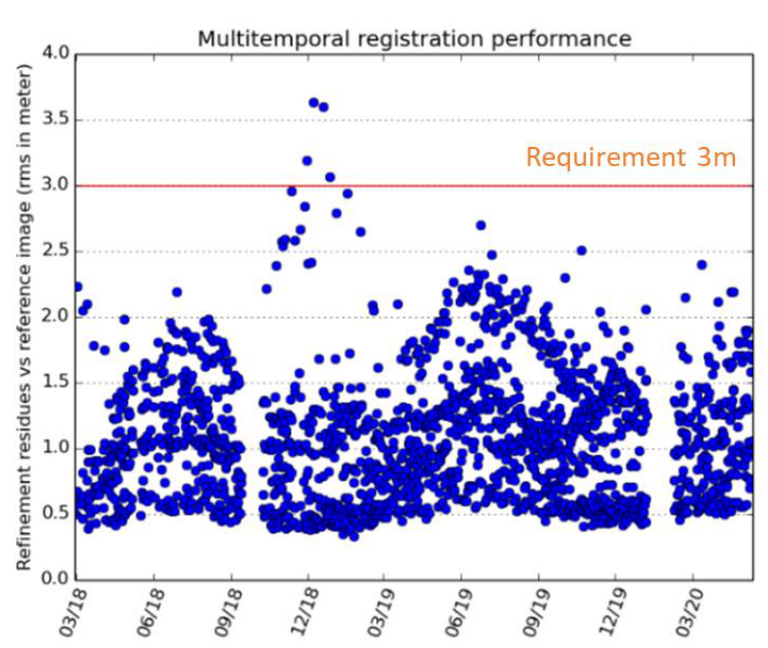
Figure 23. Multi-temporal registration performances through VM01 phase.